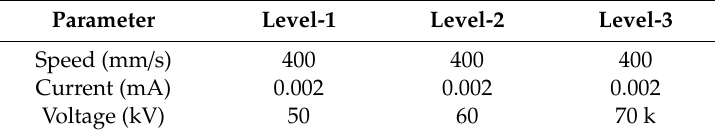
Table 7. The levels of Voltage changes.